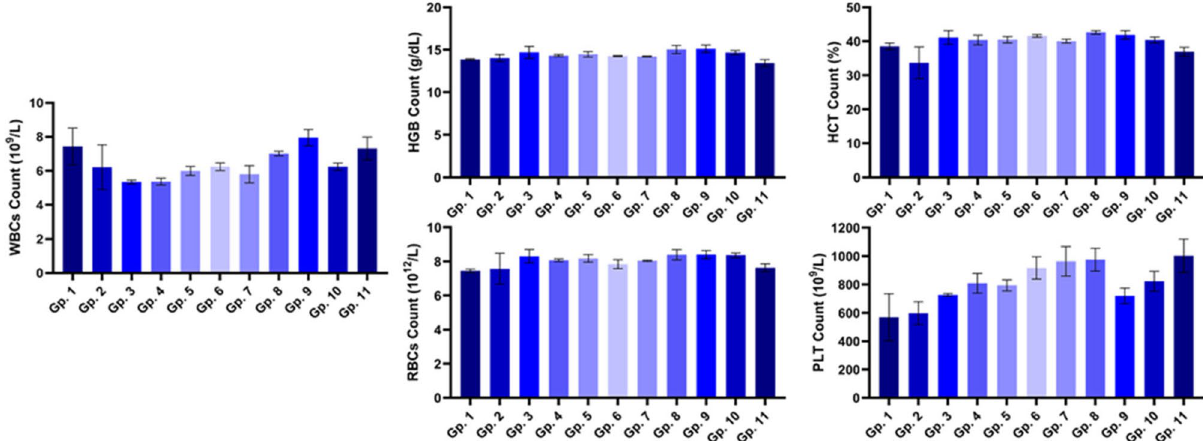
Figure 6. Effect of BV, irradiated BV, CS-NPs, and BV-loaded CS-NPs on WBCs count, HGB count, RBCs count, HCT count, and PLT count in studied groups. Gp.1: Mice injected with PBS as a control group, Gp.2: Mice injected with BV, Gp.3: Mice injected with irradiated BV, Gp.4: Mice injected with CS-NPs, Gp.5: Mice injected with BV-loaded CS-NPs, Gp.6: Infected mice with S. aureus , Gp.7: Infected mice treated with BV, Gp.8: Infected mice treated with irradiated BV, Gp.9: Infected mice treated with CS-NPs, Gp.10: Infected mice treated with BV–loaded CS-NPs, Gp.11: Infected mice treated with an antibiotic. Data were analyzed using one- way ANOVA and represented as Mean ± Standard Error of mean (SEM). -BV: Bee venom, CS-NPs: Chitosan nanoparticles, BV-loaded CS-NPs: Bee venom loaded Chitosan nanoparticles, WBCs: White blood cells, HGB: Hemoglobin, RBCs: Red blood cells, PLT: Platelets, HCT: